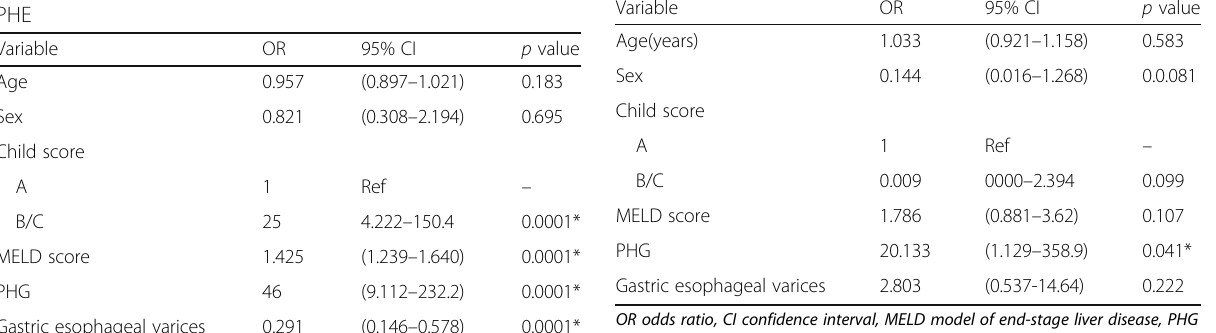
Table 3 Simple logistic regression analysis of factors affecting